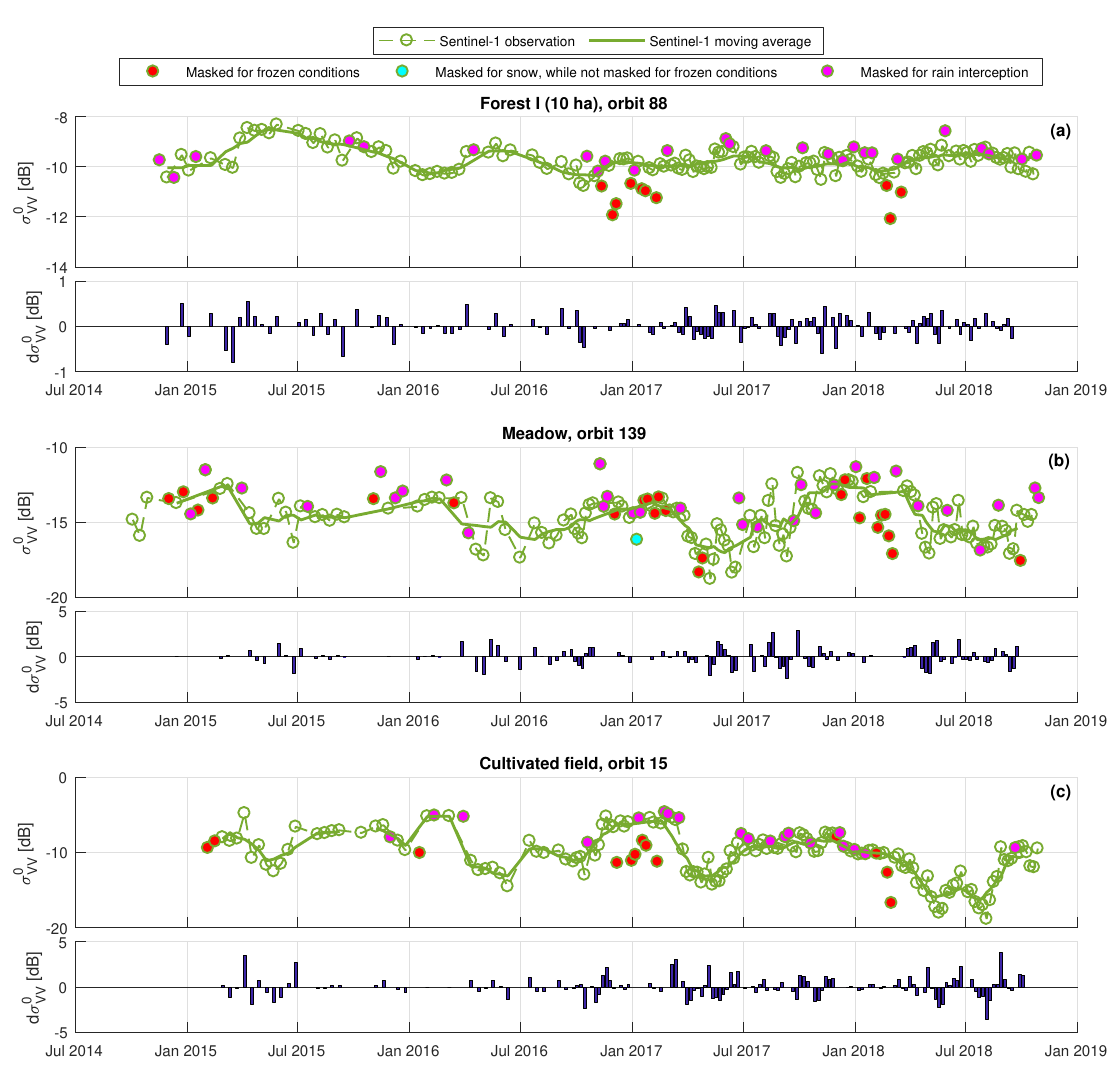
Figure 4. Sentinel-1 VV backscatter observations ( σ 0 ) and anomalies with the moving average ( d σ 0 ) VV calculated with Equation (1) using a moving average window of 40 days for ( a ) an example forest and 25 days for ( b ) an example meadow and ( c ) an example cultivated field. The Sentinel-1 observations that are masked for frozen conditions, snow or rain interception are not included in the calculation of the moving averages. The masking rules are defined in Section